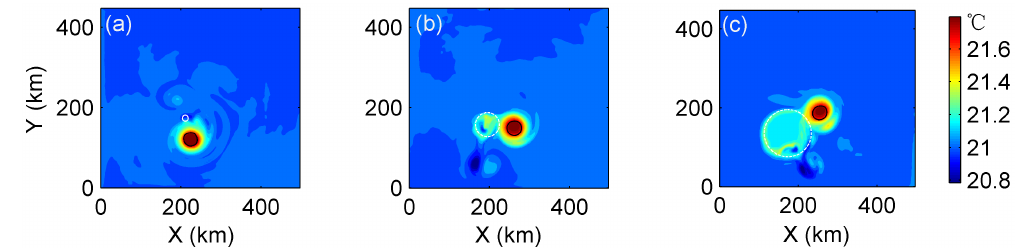
Figure 15. Eddy evolution at 100m depth during the interaction with different size seamounts with a submergence depth of 100m. (a) 15km, (b) 60km and (c) 120km. The temperature is shown in colours and the white dashed lines are the positions of the seamount; the black solid lines are the O – W parameter with a value of − 0.2 σ w .